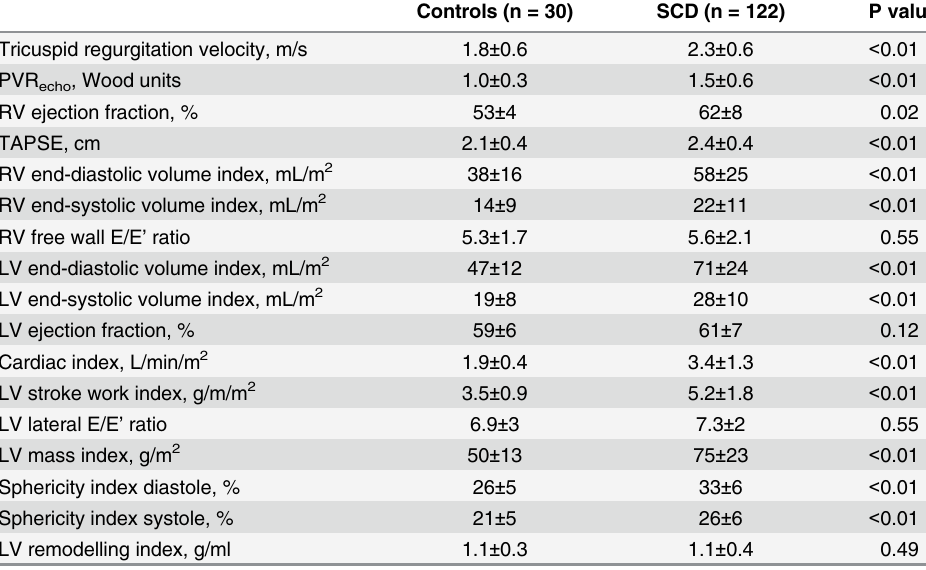
Table 2. Echocardiographic parameters in SCD